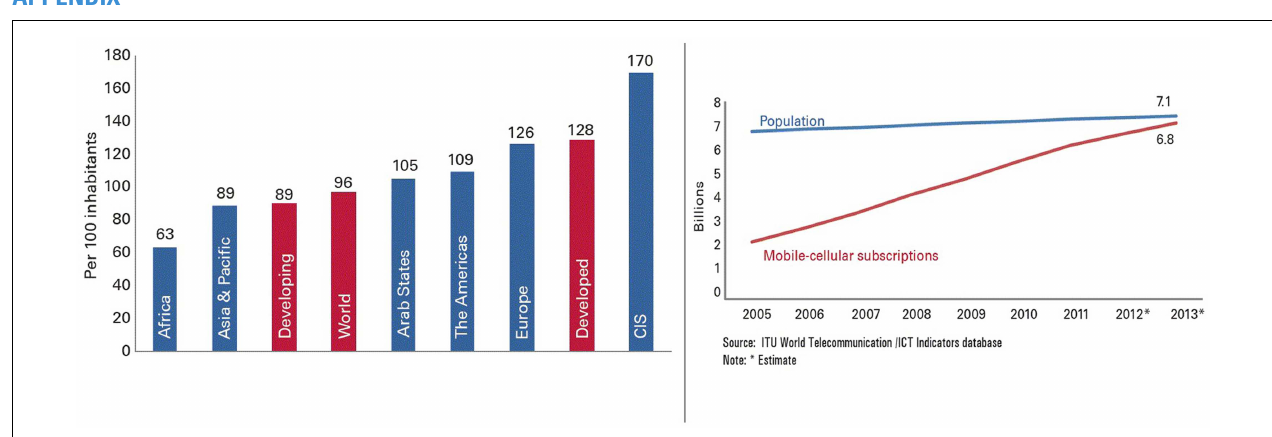
FIGUREA1 |Active mobile-broadband subscriptions per 100 inhabitants, by